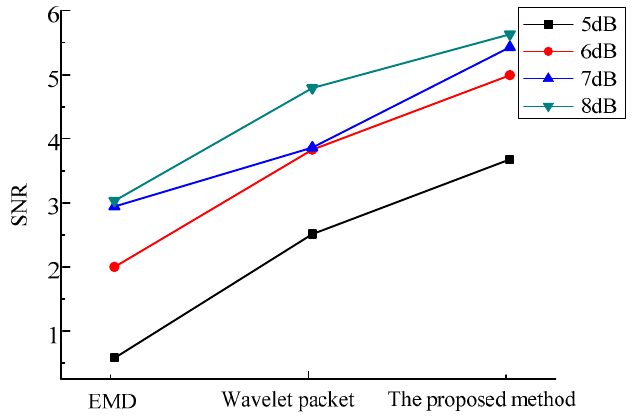
Figure 9. The SNRs of the simulation signal with different levels noise by the three methods.